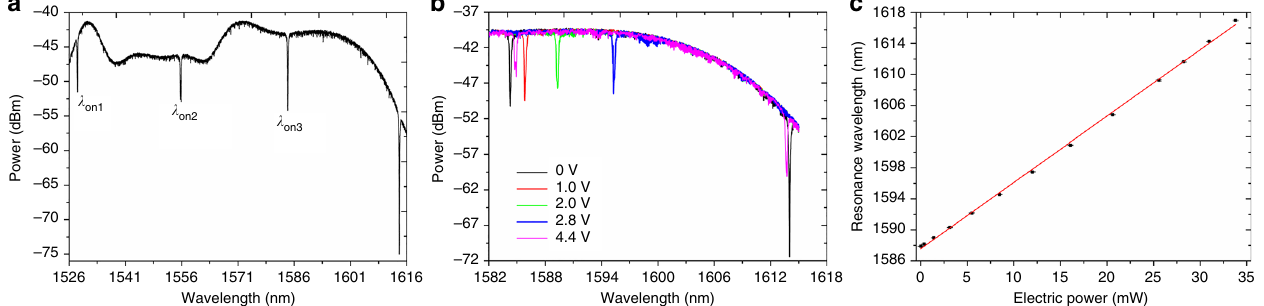
Fig. 4 MRR characterization. a Transmission spectrum from the throughput port of MRR. The three resonance wavelengths are denoted as λ on1 , λ on2 , and λ on3 , respectively. b Transmission spectra within one FSR at different applied voltages on heater 1. c Relation between resonance wavelength and heating power on heater 1. The error bars denote